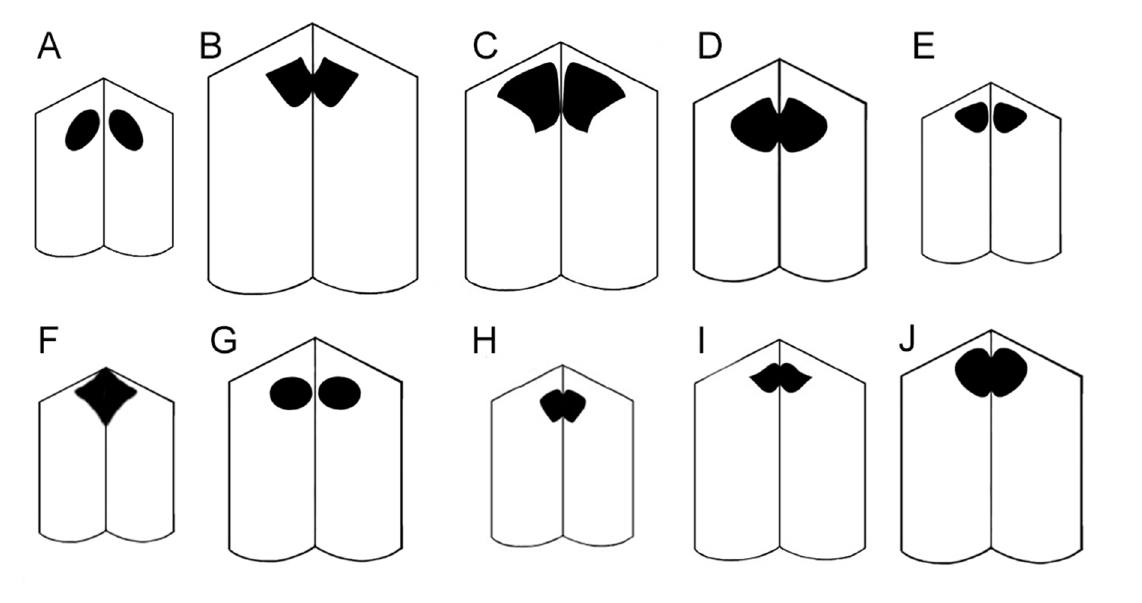
Fig. 7. Species of Trichrysis Lichtenstein, 1876, shape of black spots on S2. A . T. inops